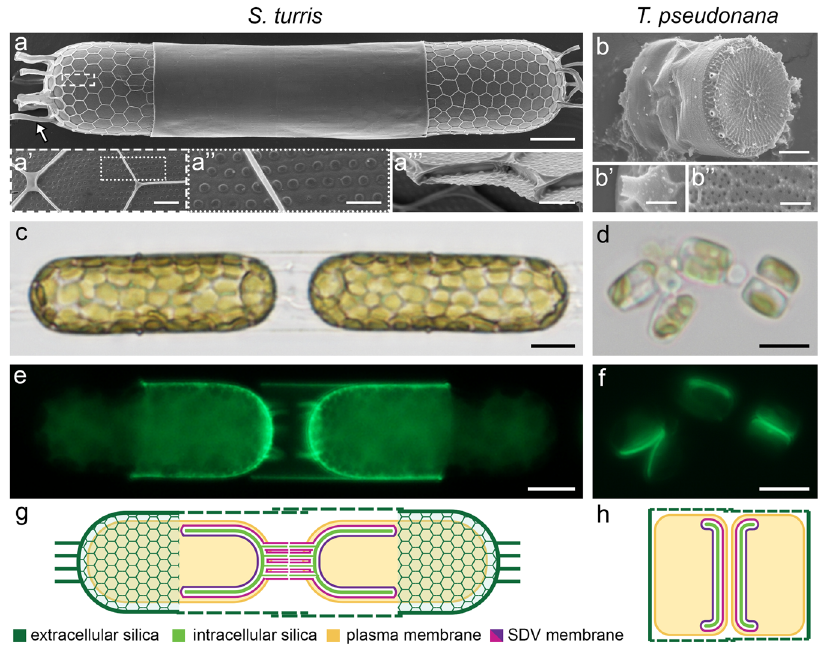
Fig. 1 | Cell architecture of S. turris (a, c, e, g) and T. pseudonana (b, d, f, h). a , b SEM images representing at least two samples. Details of the silica valve structures are shown at higher magni fi cations in the sub-panels. c , d Bright fi eld light microscope images of two S. turris cells in a chain connected through linking extensionsand several T. pseudonana cellsatdifferent stagesduring the cellcycle. e , f PDMPO fl uorescenceimageoftwodifferent S.turris daughtercellsduringvalve